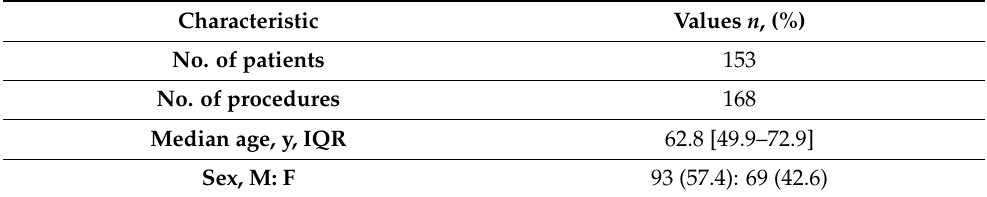
Table 1. Baseline characteristics of